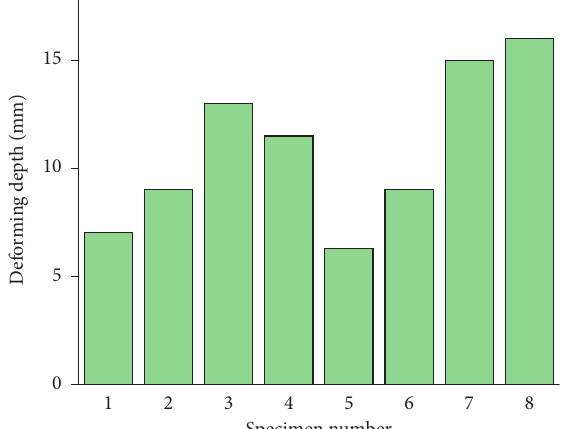
Figure 12: Absolute deforming depth. The structure type of specimen numbers 1 and 2 is AC-13-MOH. The structure type of specimen numbers 3 and 4 is MOH-AC-20. The structure type of specimen numbers 5 and 6 is MOH-MOH. The structure type of specimen numbers 7 and 8 is